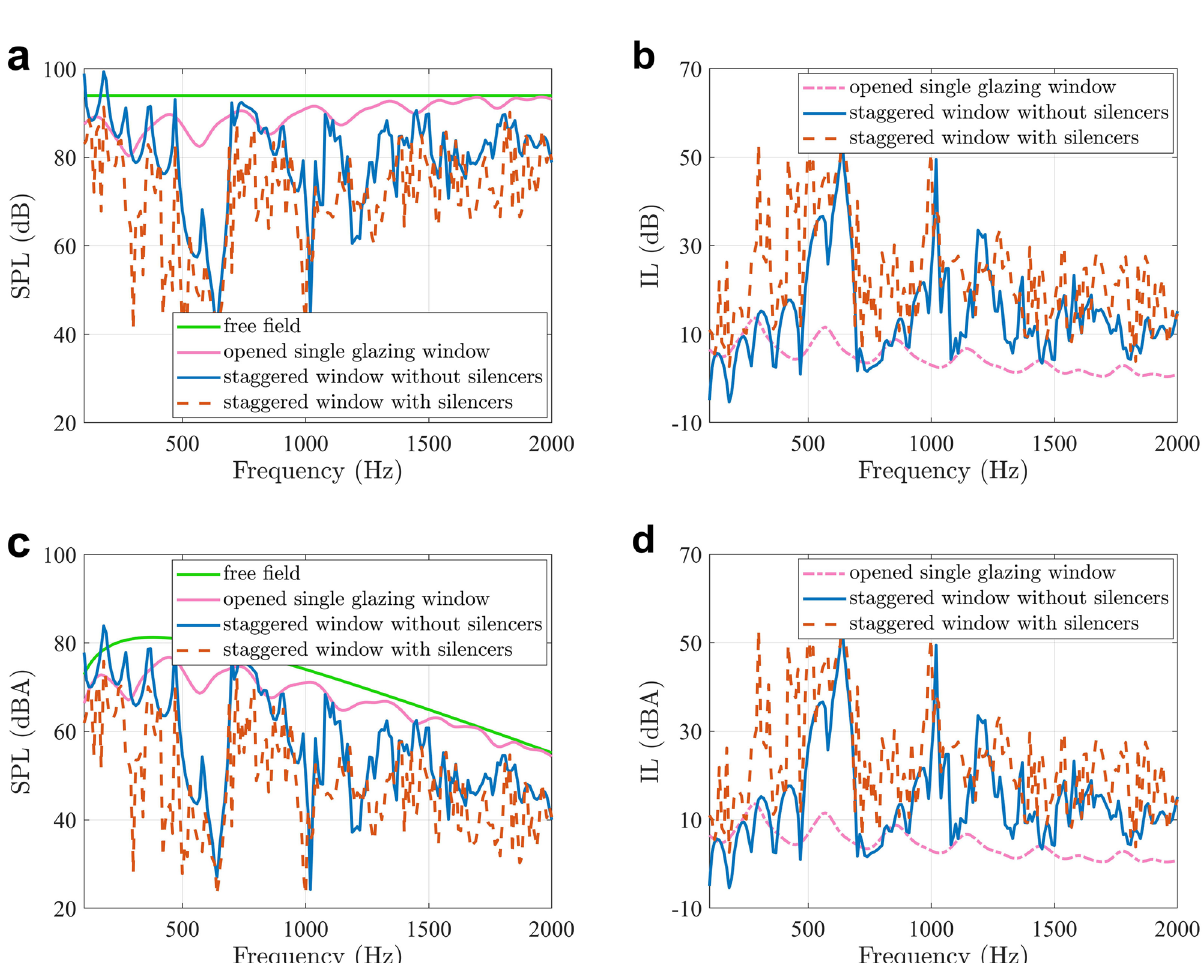
Figure 4. (a) The SPLs at the evaluation point, and (b) the insertion loss of the windows with normal incident white noise. (c) The SPLs at the evaluation point, and (d) the insertion loss of the windows with normal incident traffic